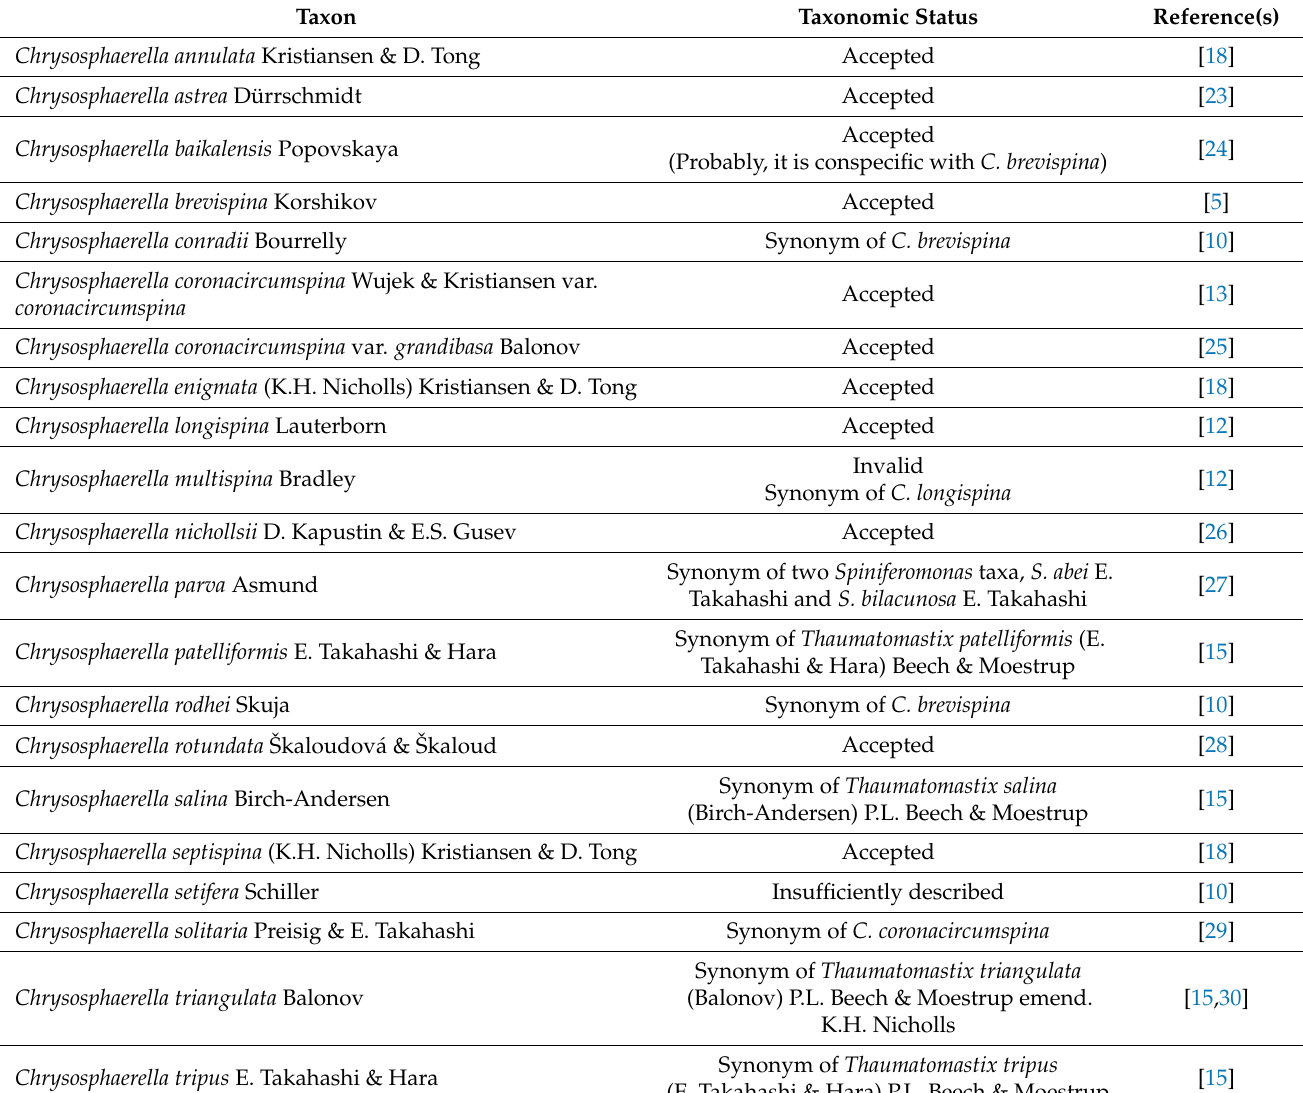
Table 1. Checklist of all previously described species of the genus Chrysosphaerella